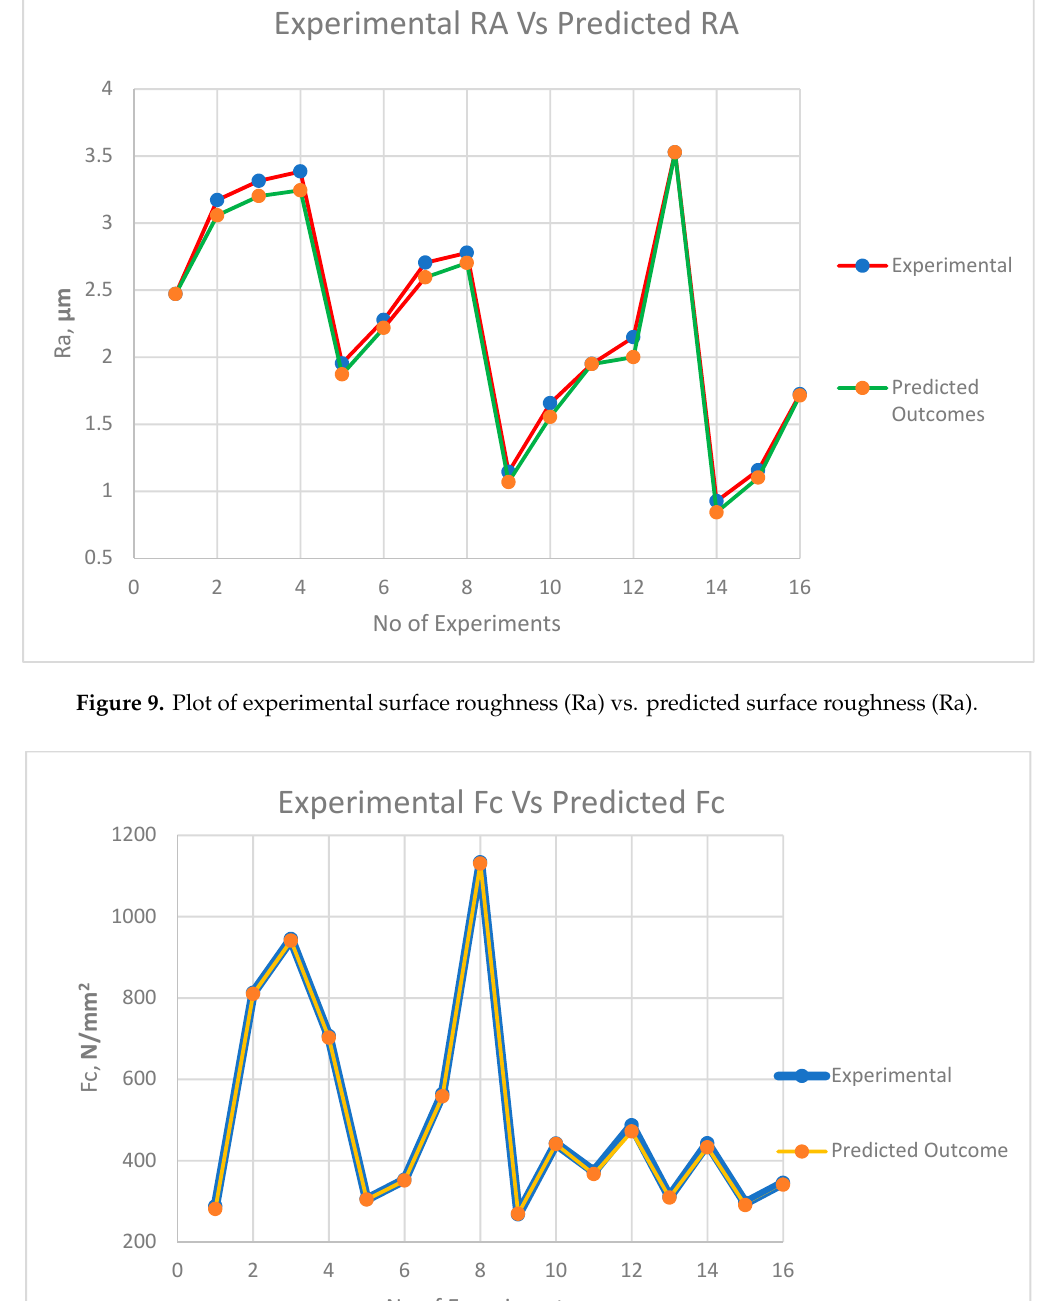
Table 8. Absolute percentage error (MAPE), root mean squared error (RMSE), and correlation coefficient (R).